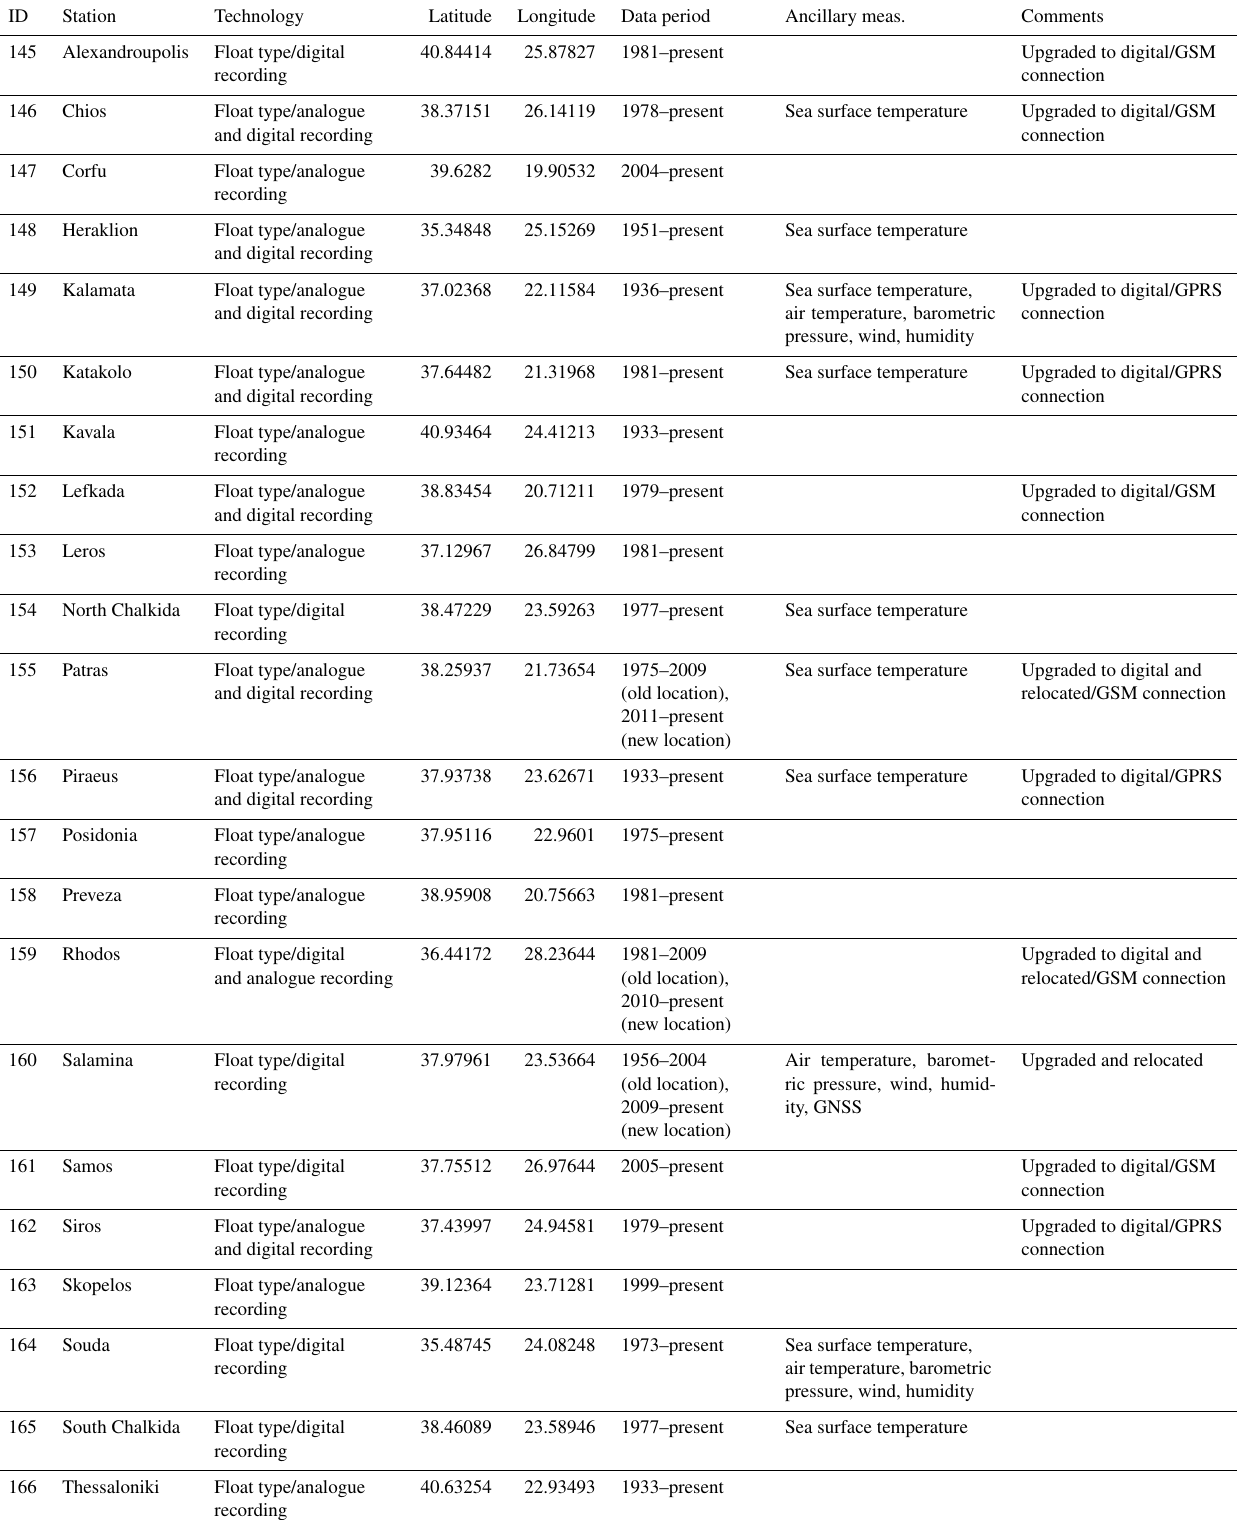
Table A16. Network of stations operated by the Hellenic Navy Hydrographic Service,